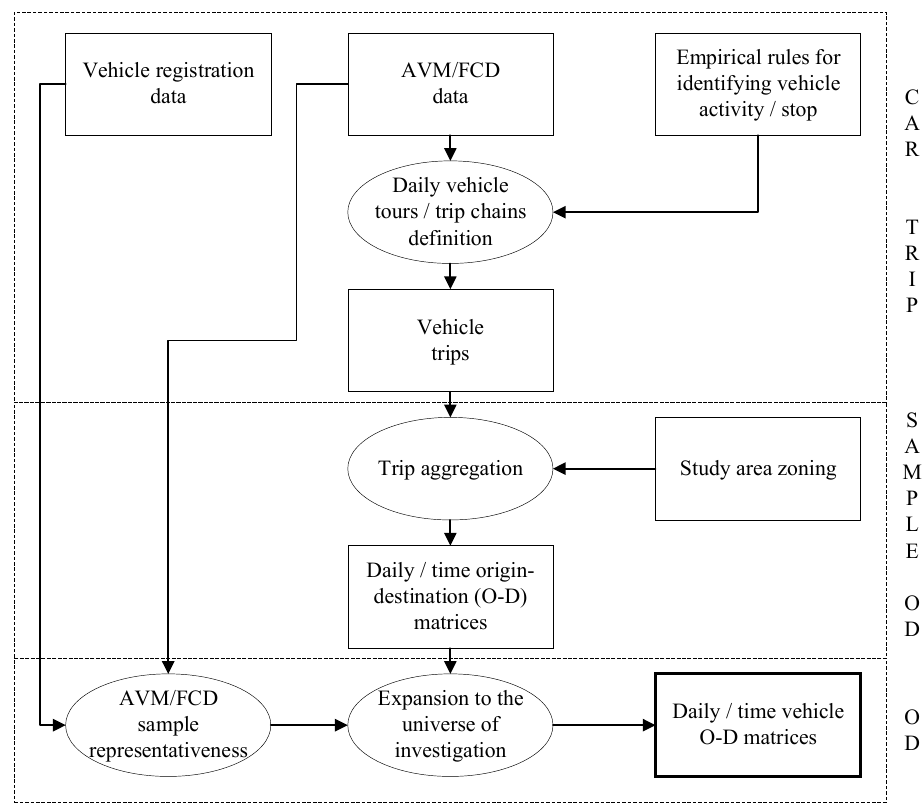
Figure 1. The proposed methodology.